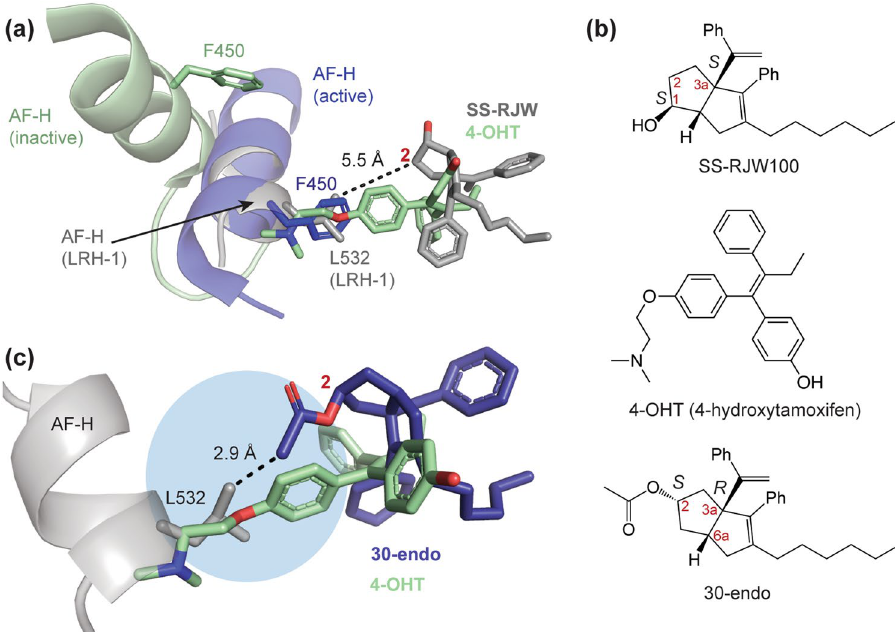
Figure 8. Potential for exploiting the SS-RJW100 binding mode to generate LRH-1 antagonists. ( a ) Superposition the ligands (sticks) and AF-H (cartoon) from three structures: oestrogen receptor gamma in the active state (dark blue, from PBD 2GP7), bound to 4-hydroxy tamoxifen (4-OHT, pale green, from PDB 2GPU) 45 , and LRH-1-SS-RJW100 (grey). The clash of 4-OHT with residue L532 is shown. ( b ) A comparison of chemical structures of SS-RJW100, 4-OHT, and 30-endo ( c ) Docking of the compound 30-endo (dark blue sticks) 33 in the SS-RJW100 structure as an example of how bulky groups could be added to the SS-RJW100 scaffold to extend toward the AF-H. The acetoxy moiety appended to the ligand bicyclic core at position 2 is within 3 Å of the AF-H and nearly overlaps with TAM. The blue circle indicates space that could accommodate bulk and displace the activation function helix (AF-H) in a similar manner to